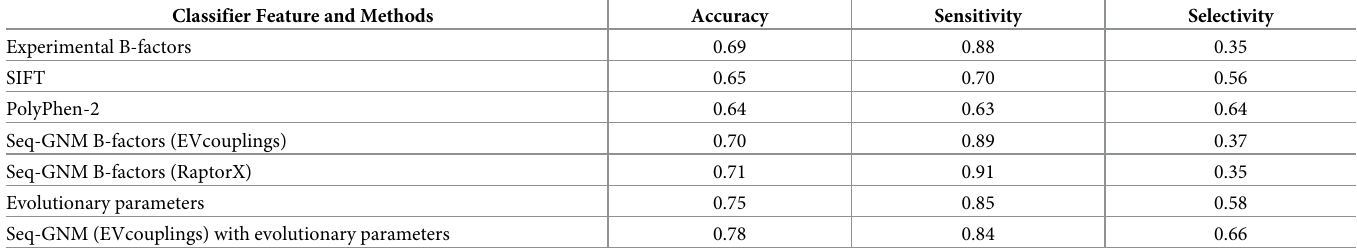
Table 1. The disease prediction data showing the accuracy, sensitivity, and the selectivity of Seq-GNM compared with experimental B-factors, SIFT, PolyPhen-2 and evolutionary